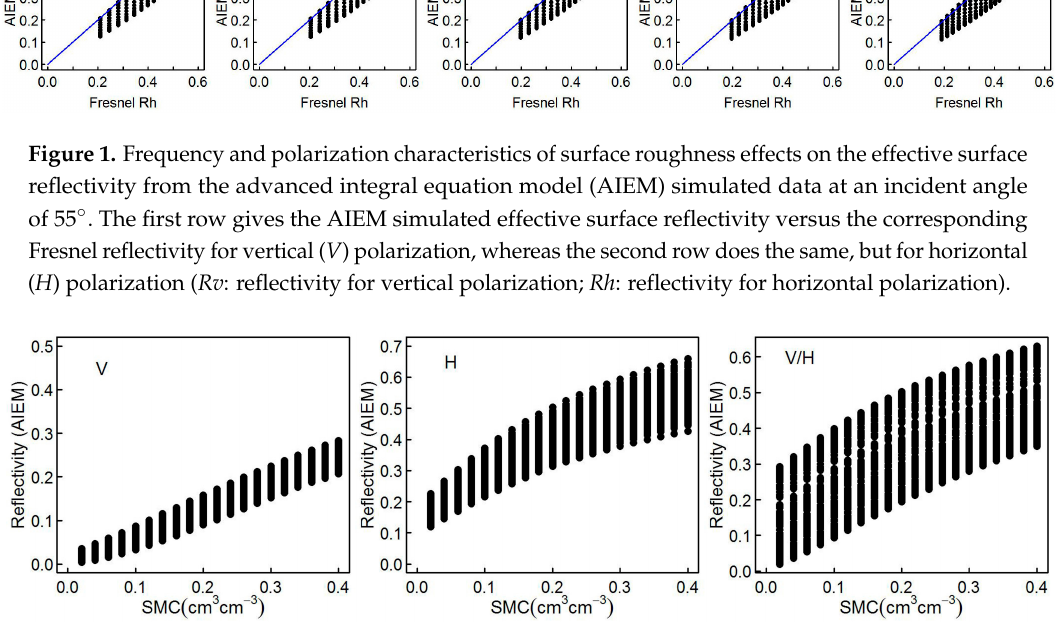
Figure 2. The effective surface reflectivity from the AIEM simulated data versus soil moisture content (SMC) at a frequency 10.7 GHz and an incident angle 55 ° for vertical ( V ) polarization, horizontal ( H ) polarization, and the ratio of two polarizations ( V/H ).